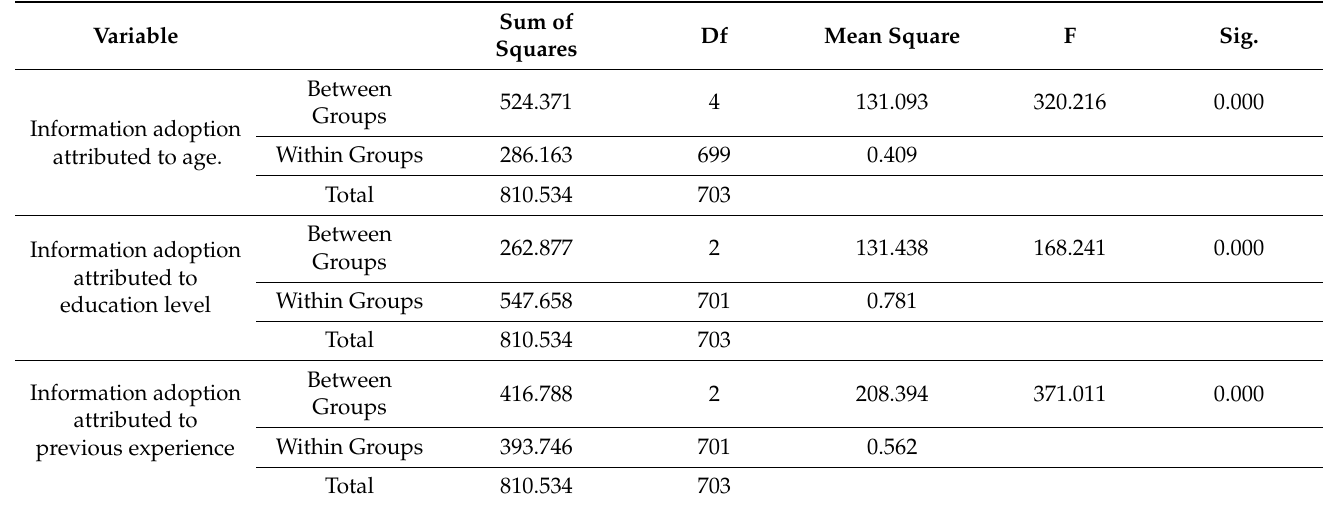
Table 9. ANOVA analysis of respondents’ information adoption (IA) attributed to age, education level, and previous experience.